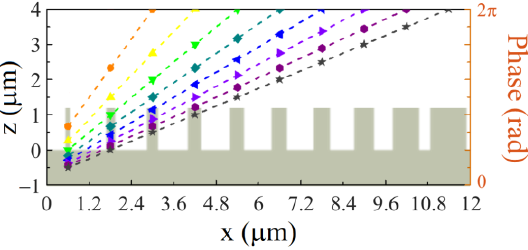
Figure 4. Schematic of the discretely tunable beam deflector. The dashed lines and dots represent the varied supercells with different numbers of nanopillars of metasurface deflectors.